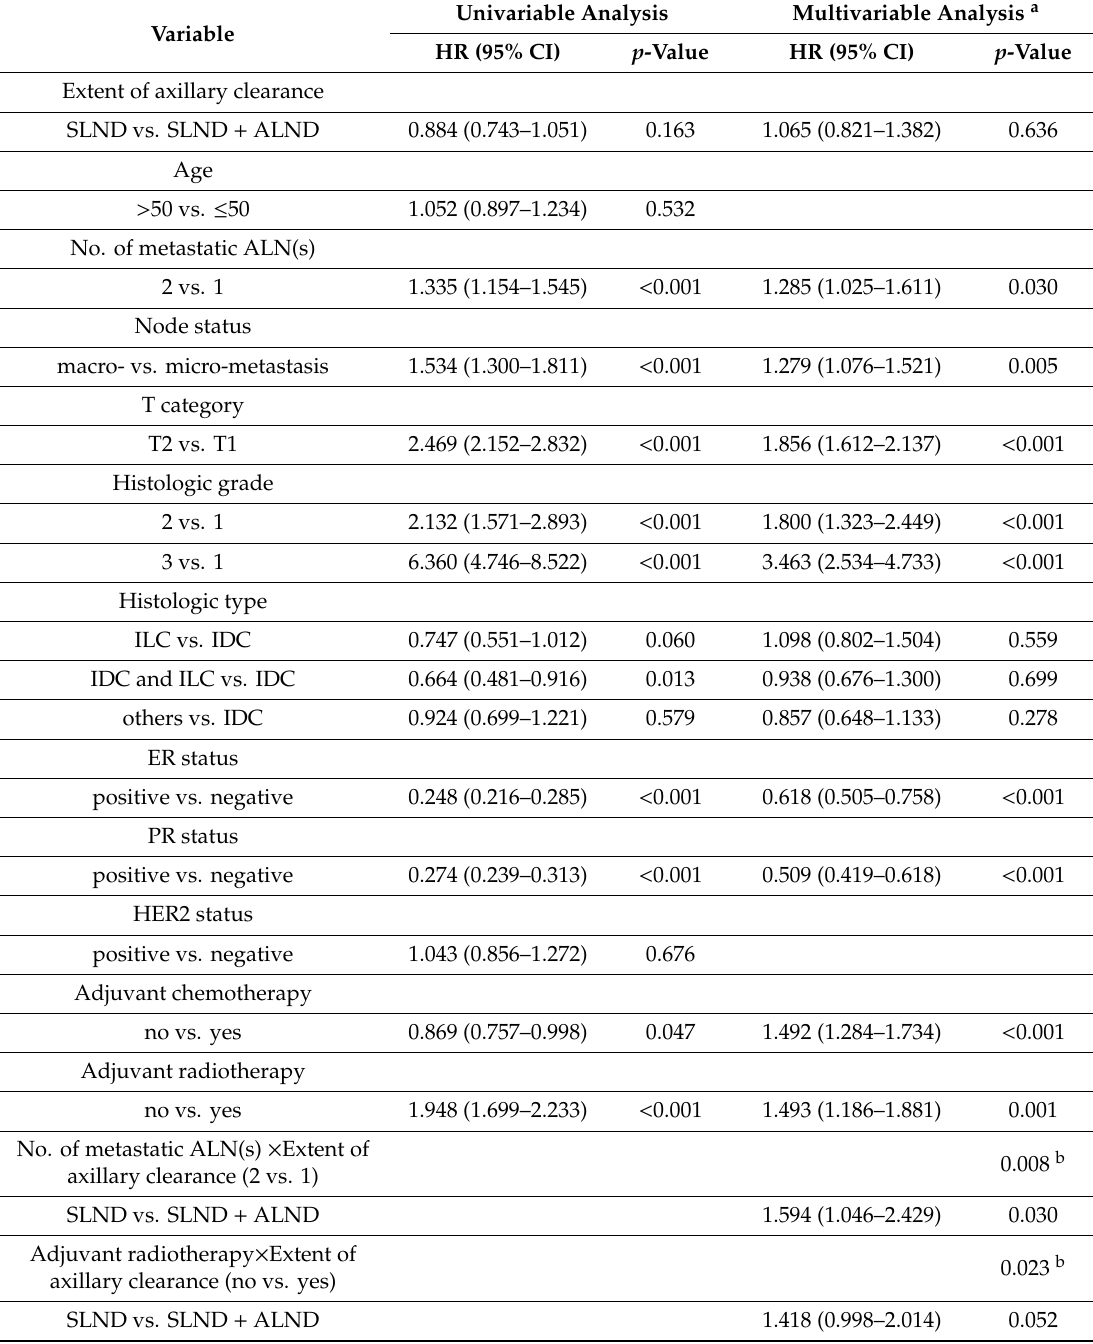
Table 2. Multivariable analysis for breast cancer-specific mortality among the Z0011-comparable patients.